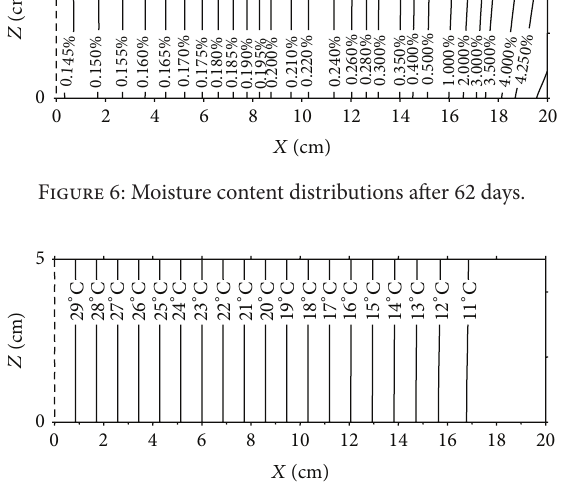
Figure 7: Temperature distributions after 62 days.